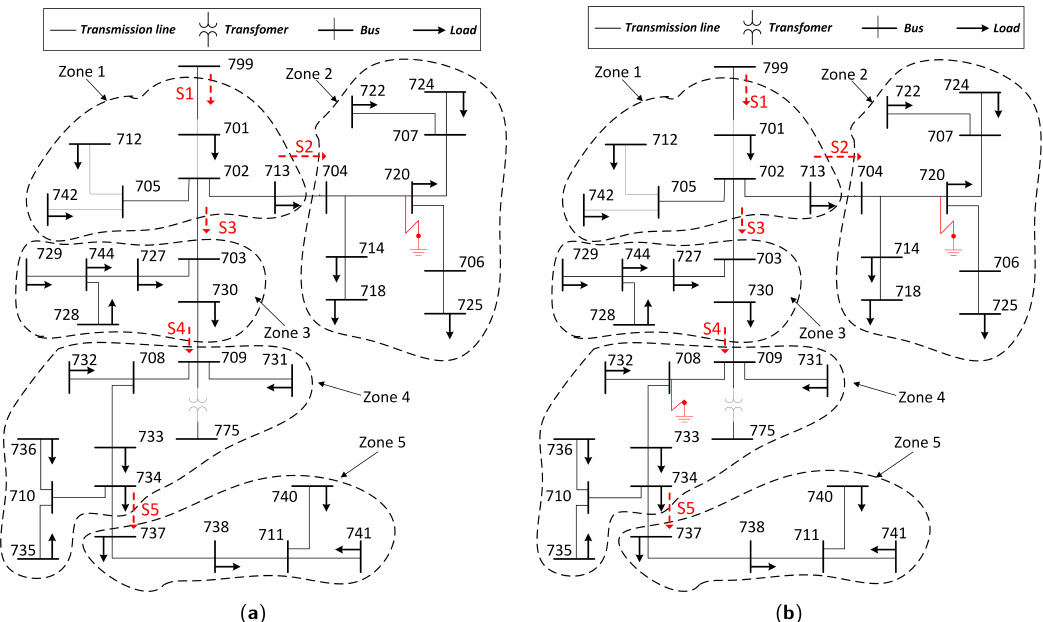
Figure 3. IEEE 37 node test feeder divided into 5 zones for fault detection and localization. Fault is induced at bus 720 ( a ). Fault is induced at bus 720 and 708 ( b ). (Current measurements at the zone boundaries are marked in red).